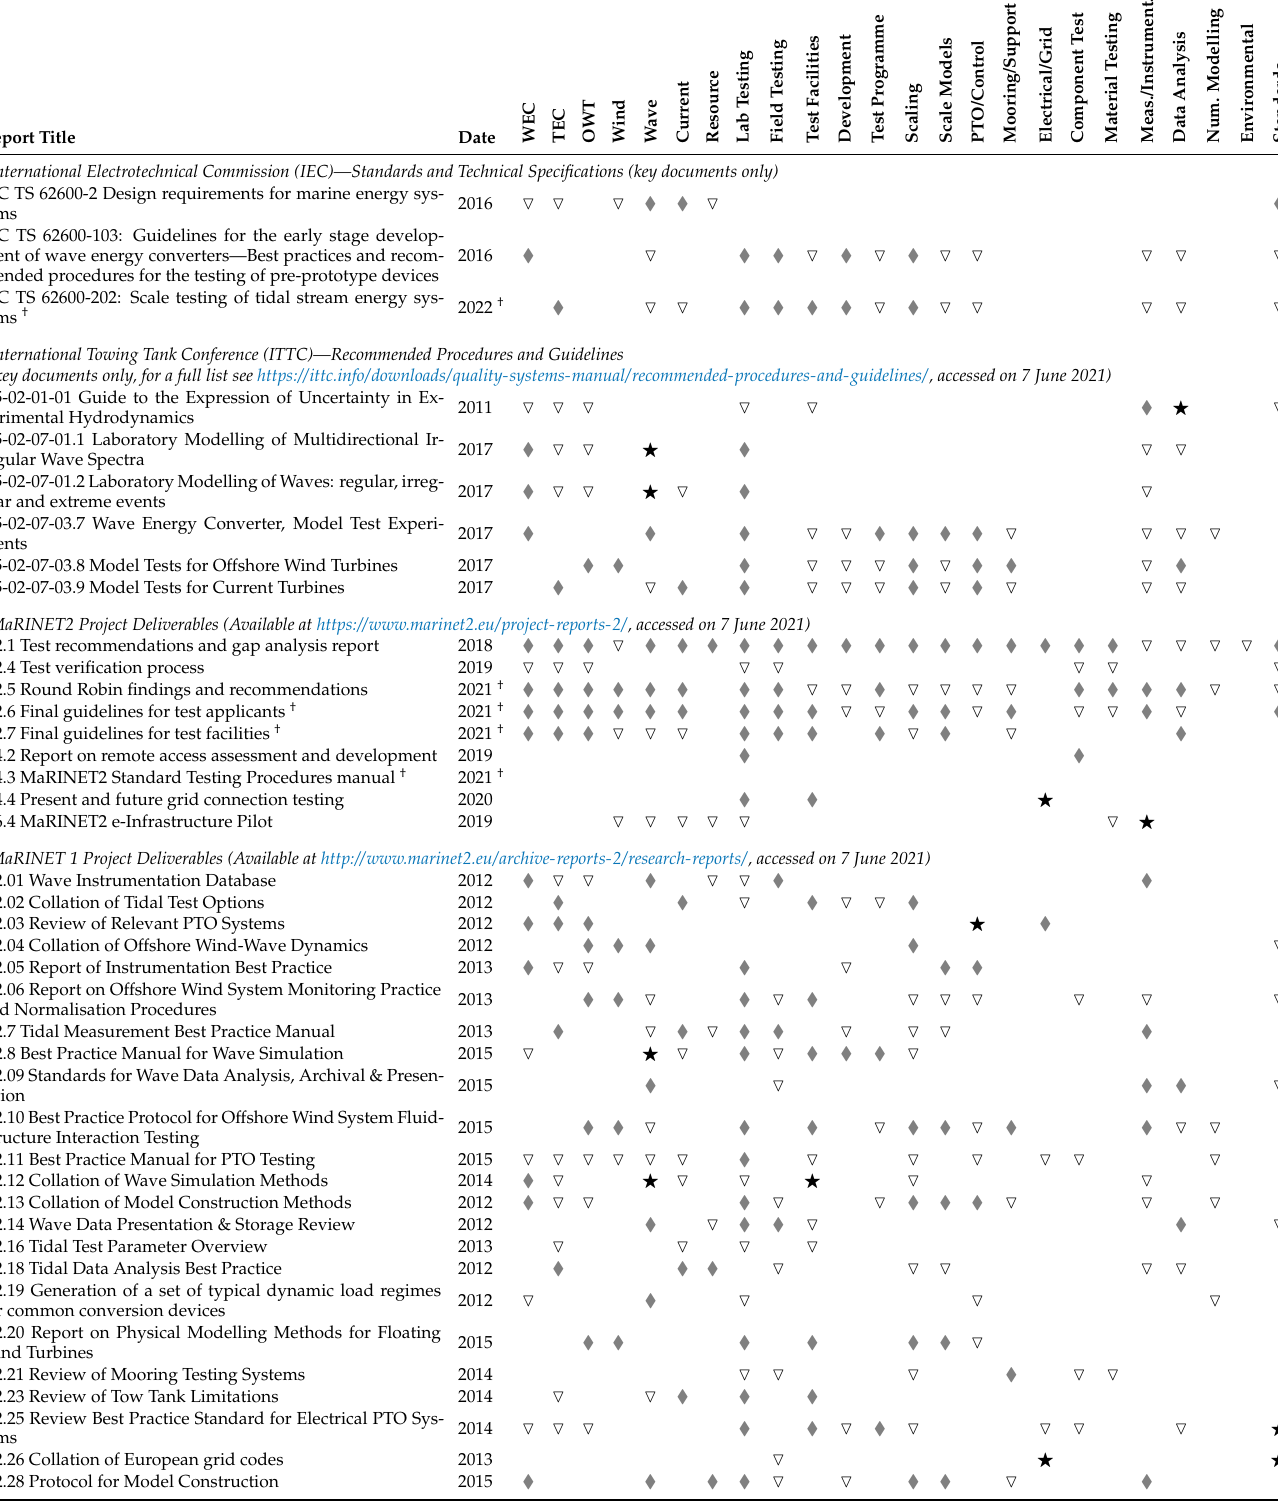
Table A1. Tabular summary of key topics covered by guidance documents. Symbols give an approximate level of detail and relevance for each topic: (cid:79) briefly covered/partial relevance, (cid:7) relevant/covered in detail, (cid:70) covered in thorough